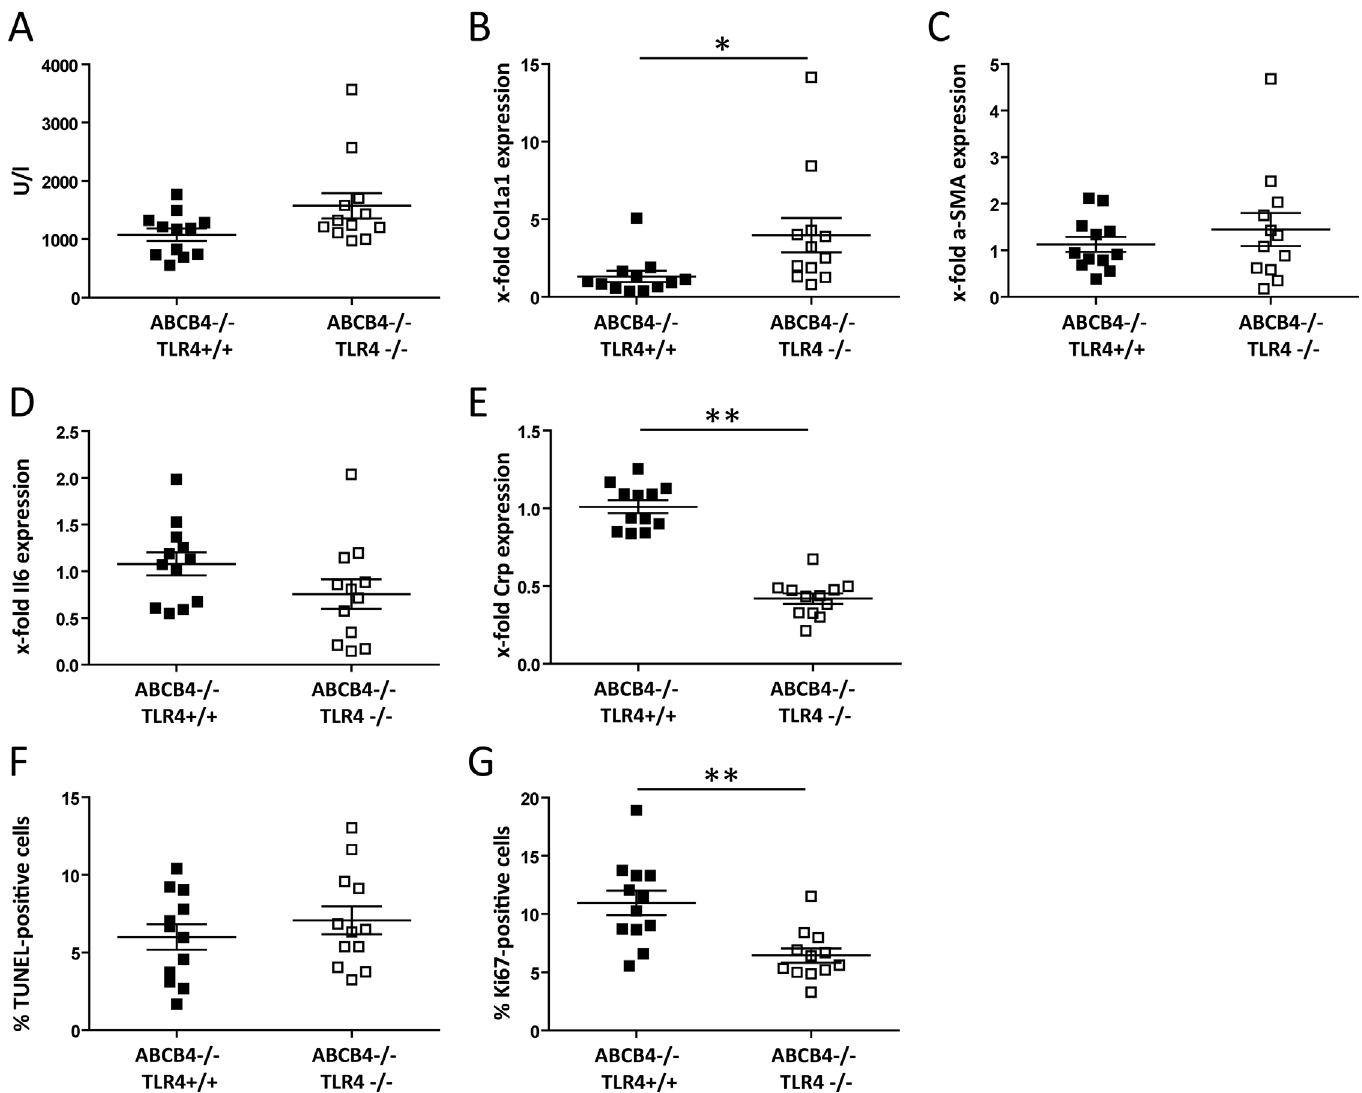
Fig 4. TLR4 deficiency protects against DEN-induced liver injury in fibrotic liver. ABCB4-deficient and ABCB4/TLR4-double-deficient mice were subjected to DEN at 16 weeks of age (n = 12 per line; 6 males, 6 females). (A) Plasma ALT activities, measured in U/l. (B) Relative hepatic Col1a1 mRNA expression. ABCB4 -/- :TLR4 +/+ mice were set as 1. (C) Relative hepatic a-SMA mRNA expression. ABCB4 -/- :TLR4 +/+ mice were set as 1. (D) Relative hepatic Il6 expression. ABCB4 -/- : TLR4 +/+ mice were set as 1. (E) Relative hepatic Crp expression. ABCB4 -/- :TLR4 +/+ mice were set as 1. (D) Hepatocellular apoptosis rate. (E) Hepatocellular proliferation rate. * p < 0.05; ** p <